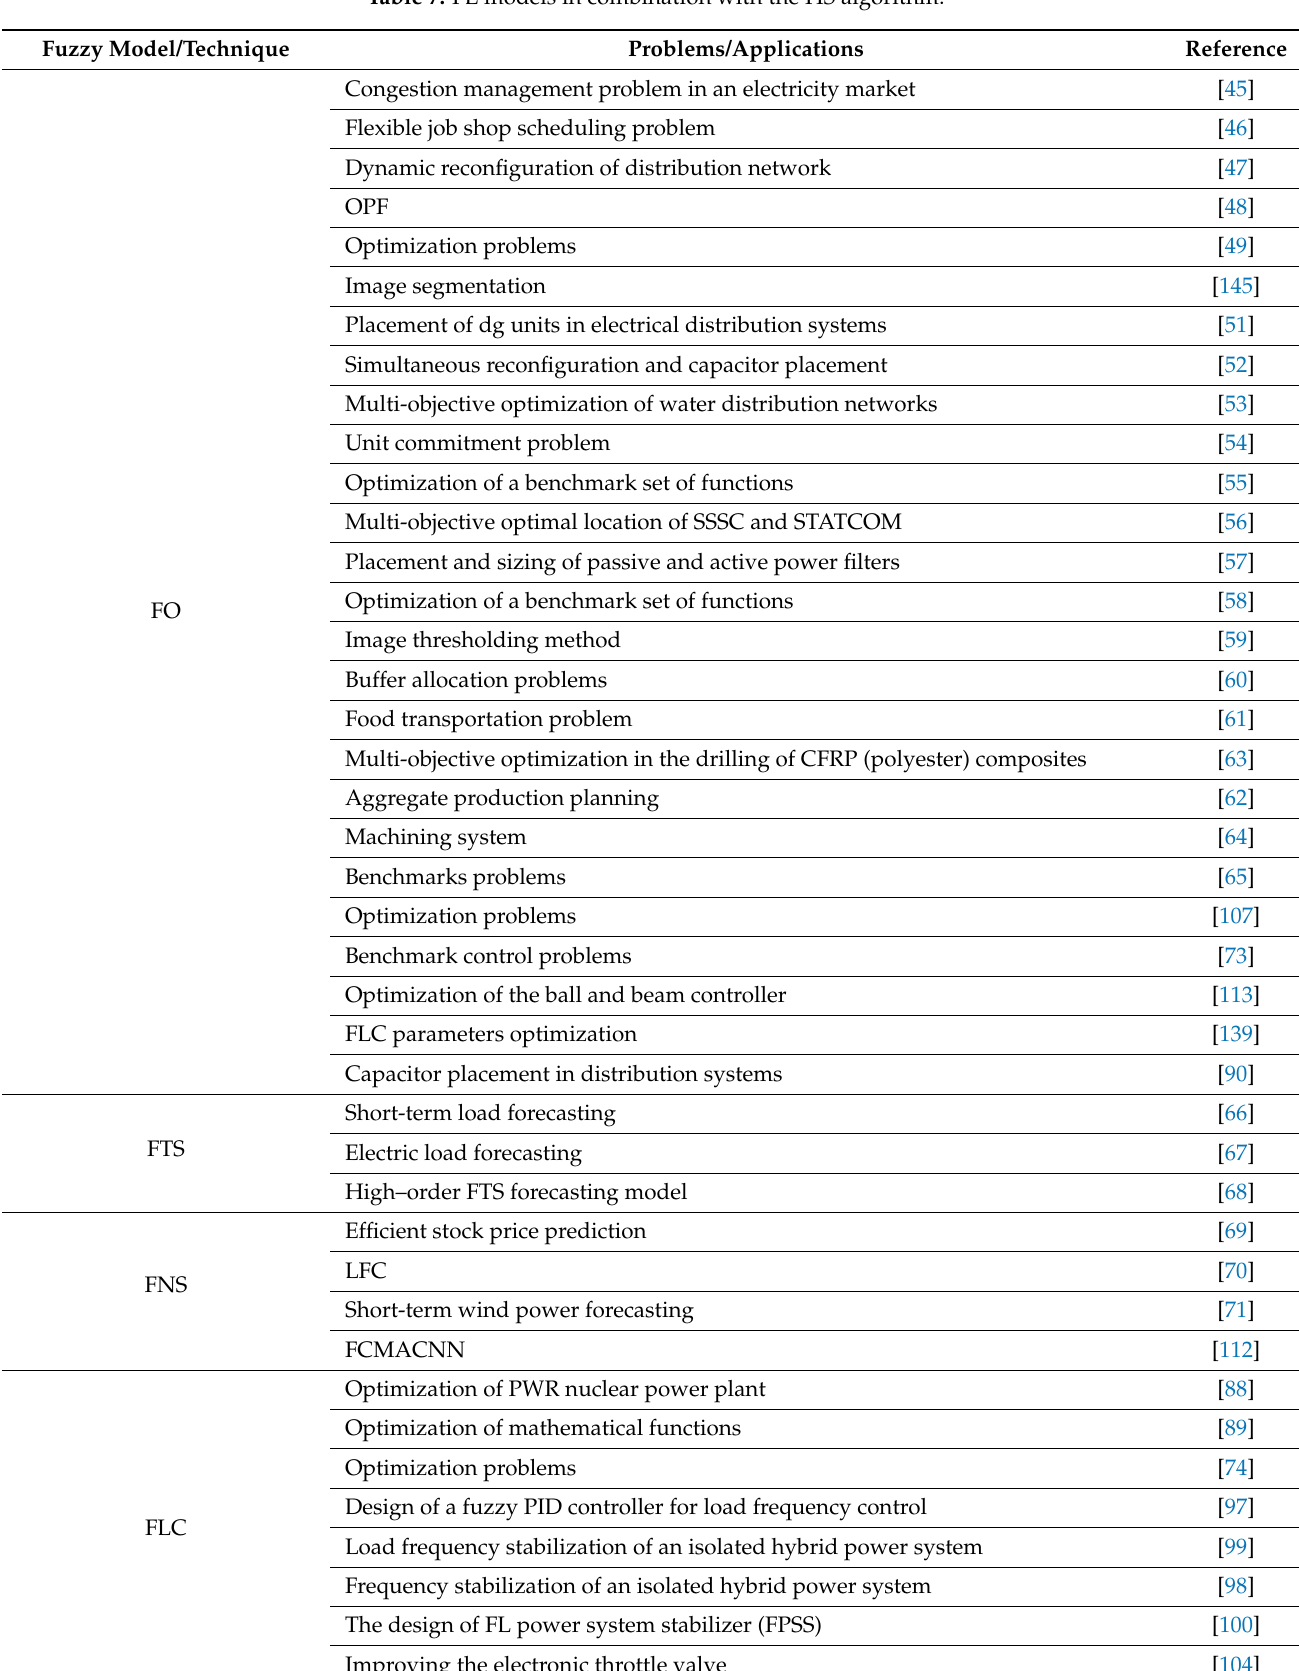
Table 7. FL models in combination with the HS